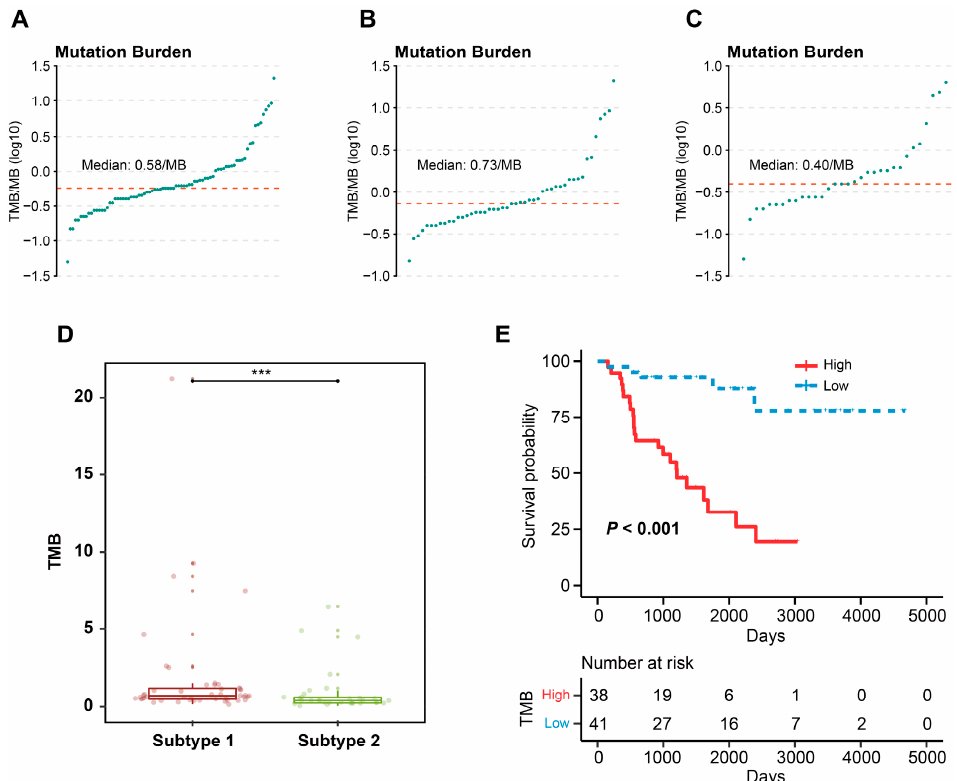
Figure 8. Somatic variants and TME-related subtypes. ( A ) Waterfall plot visualizing the top 20 highly mutated genes of subtype 1. ( B ) Waterfall plot visualizing the top 20 highly mutated genes of subtype 2.